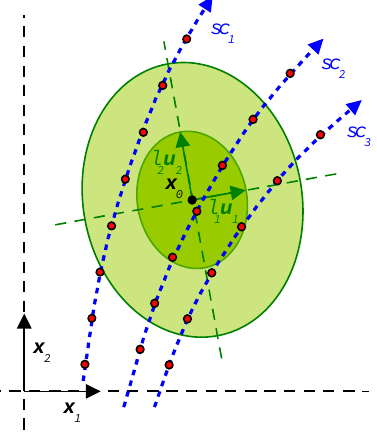
Fig. 1. Illustration of least-squares gradient computation in a 2- dimensional setting. The algorithm uses data obtained in a set of points in space-time. In this example, the data are acquired by three spacecraft (red dots on the dotted spacecraft trajectories); the method can deal with any number of spacecraft. The approximation error in each data point grows with its distance from x 0 , where the gradient is computed. This distance is measured in a frame ( l 1 u 1 , l 2 u 2 ) that may be rotated and scaled relative to the original frame. Points on the ellipse with semi-axes l 1 and l 2 are assigned a unit distance. Points inside the ellipse (dark shaded area) correspond to smaller distances and therefore a smaller error. Points outside that ellipse (lightly shaded region) will have a larger error so that they are less relevant, thus reflecting the homogeneity condition. Points outside the shaded regions are ignored.